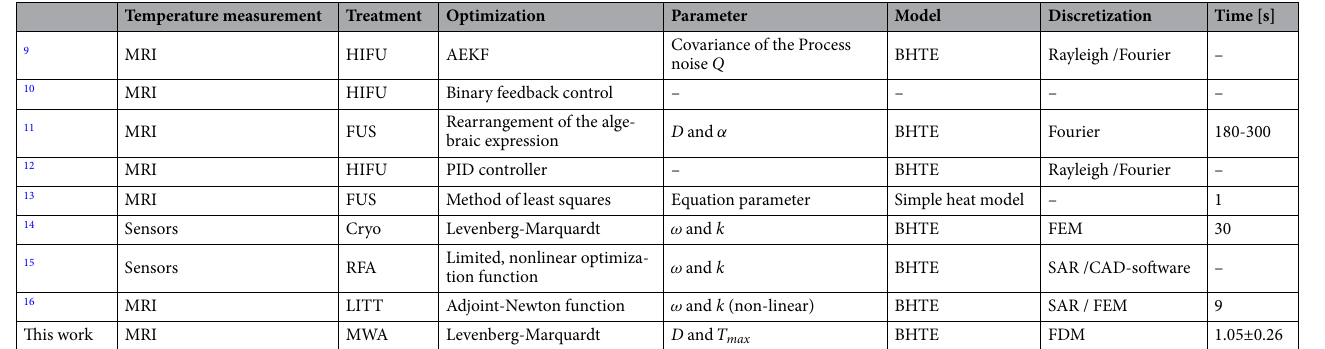
Table 1. Summary of the related work. AEKF, adaptive extended Kalman filter; D , thermal diffusivity; α , energy absorption rate; ω , perfusion; k , thermal conductivity; FEM, finite elements method; SAR, specific absorption